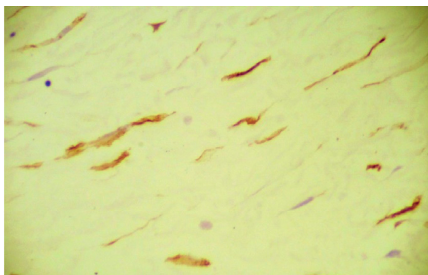
Figure 5: FEP stromal cells positive for CD34 staining (immu- nochemistry